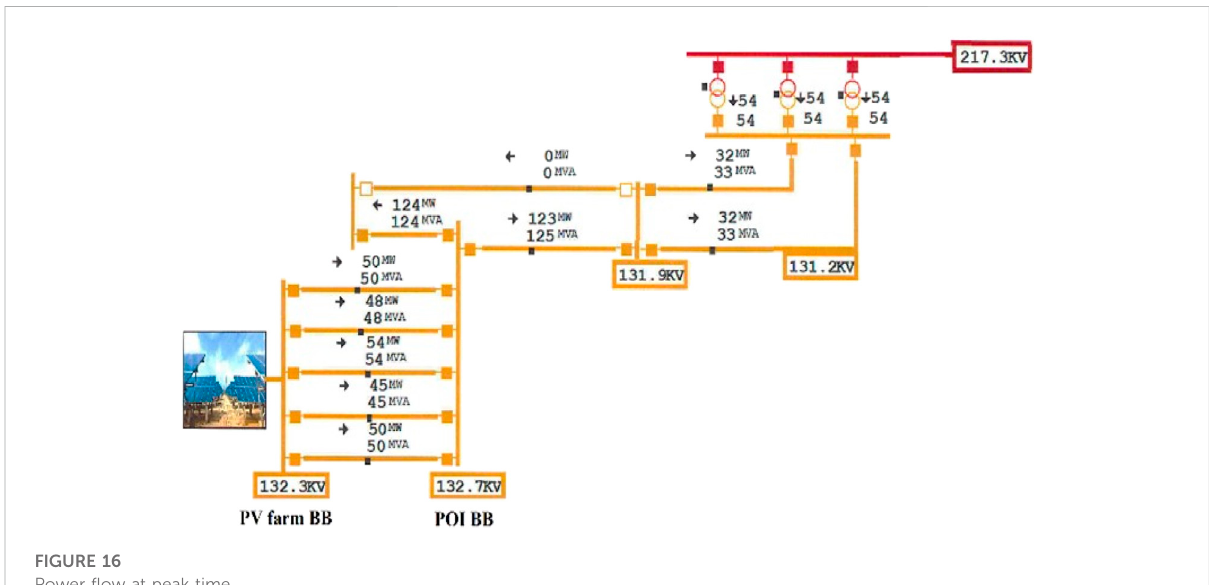
FIGURE 16 Power fl ow at peak